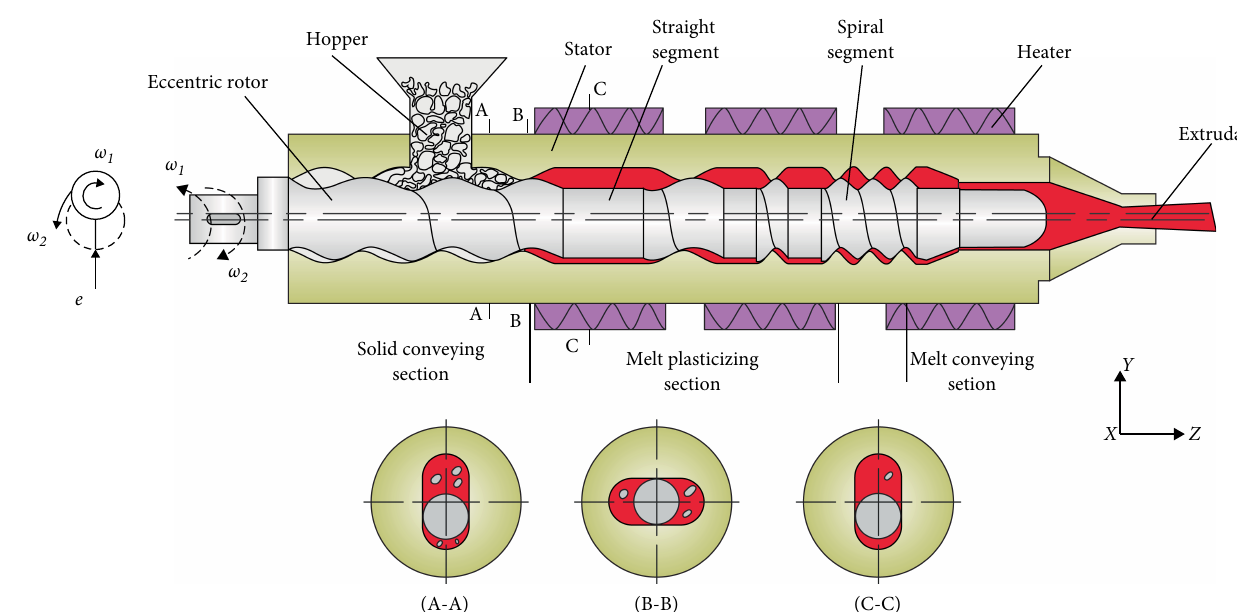
Figure 1: The schematic diagram of the